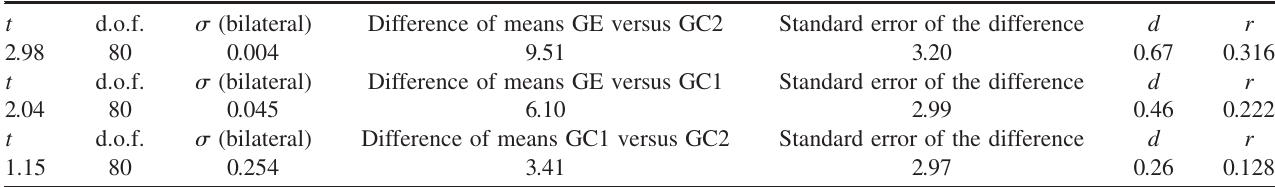
COMPARATIVE STUDY OF THE EFFECTIVENESS . . TABLE II. Student’s t -test for the equality of means for independent samples ( p < 0 : 05 ), with Cohen’s d and effect size coefficient r . Hyp.E.G. versus Trad.C.G. (top), Hyp.E.G. versus Schem.C.G. (middle), Schem.C.G. versus Trad.C.G. (bottom). CG1, control group 1; CG2, control group 2; GE, experimental group.